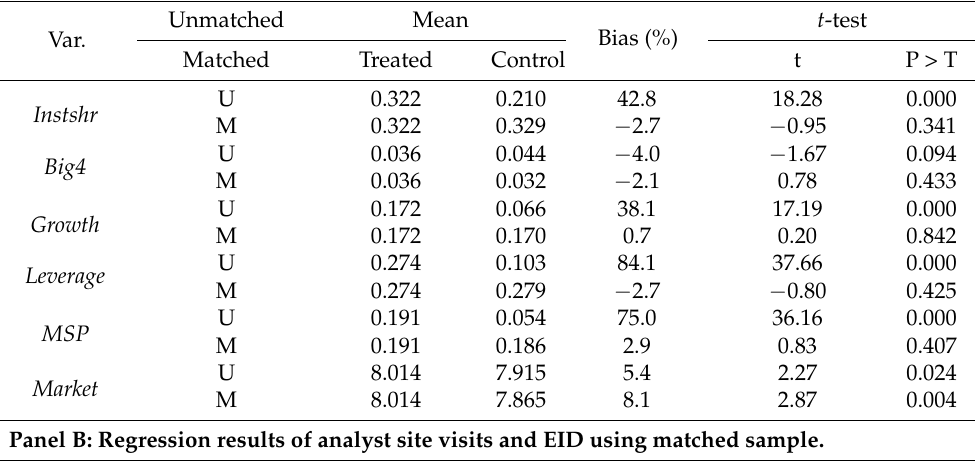
Panel B: Regression results of analyst site visits and EID using matched